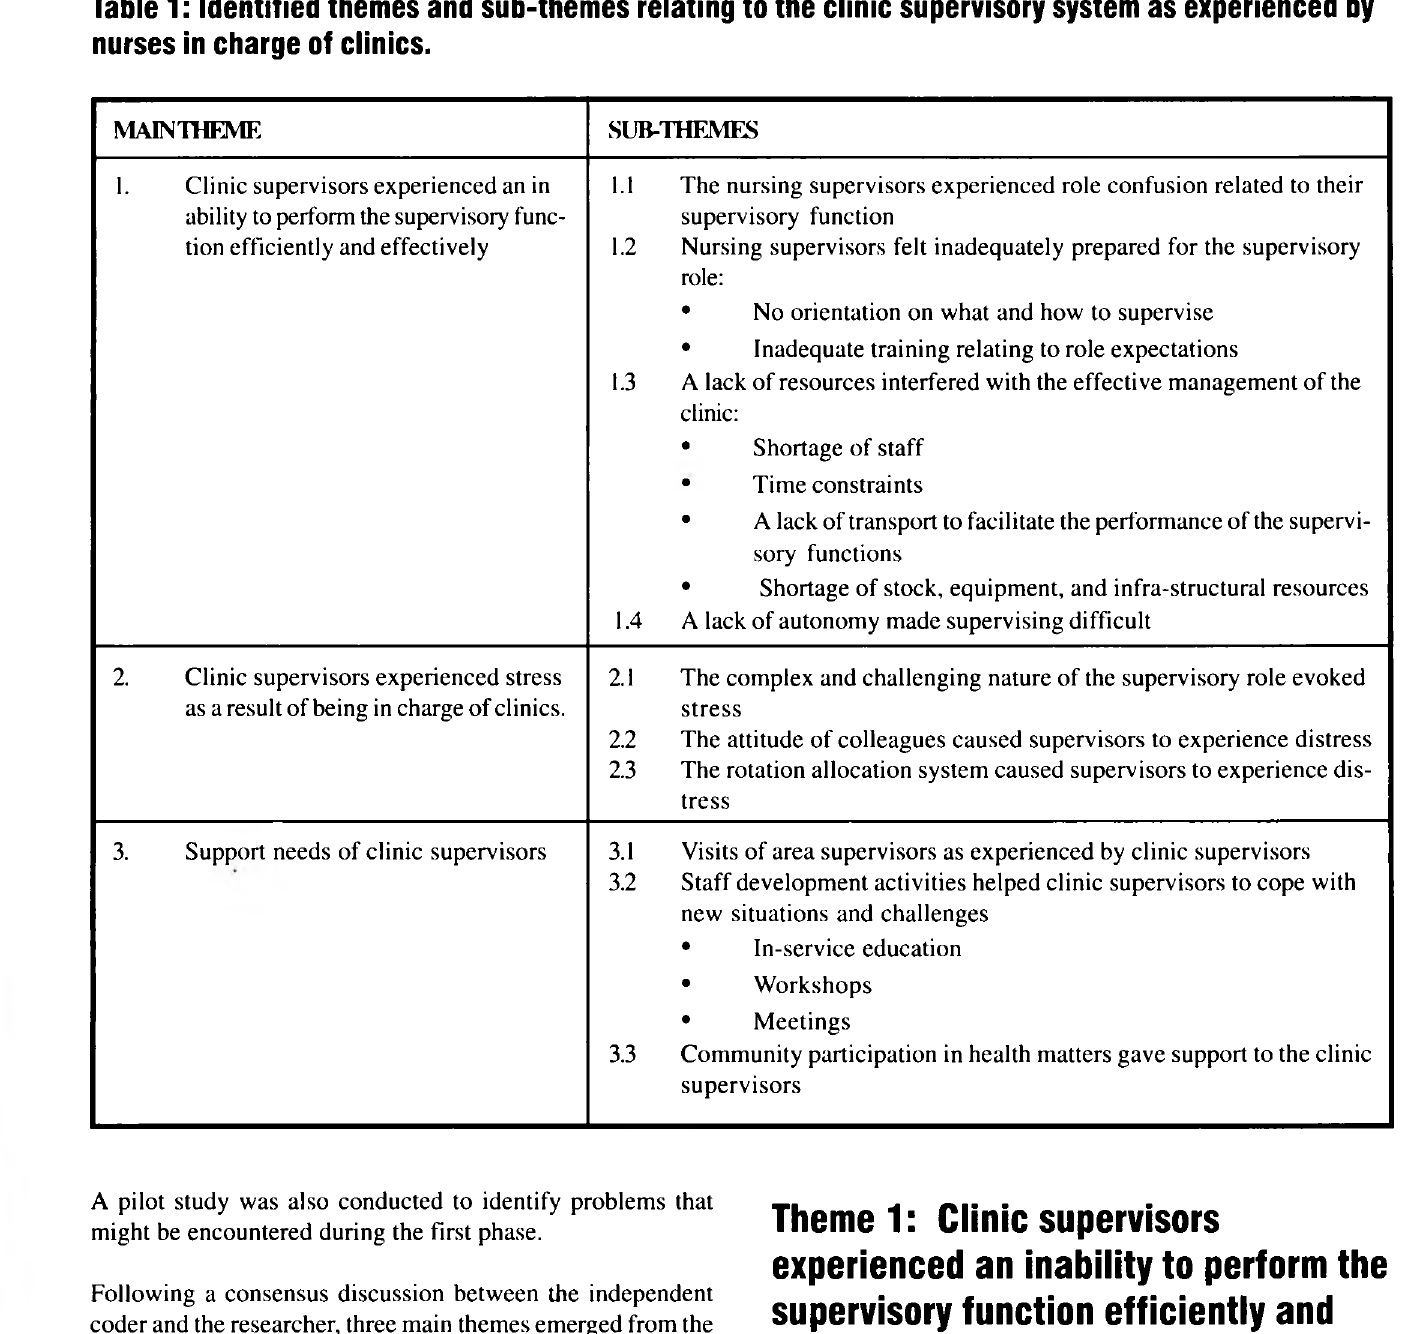
Table 1 : Identified themes and sub-themes relating to the clinic supervisory system as experienced by nurses in charge of